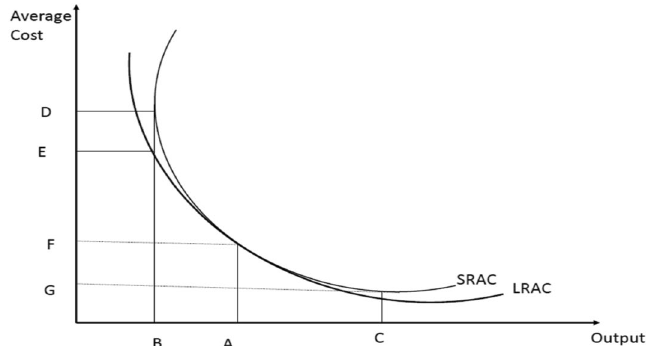
Fig. 4 Cost-based theory of capacity utilization and